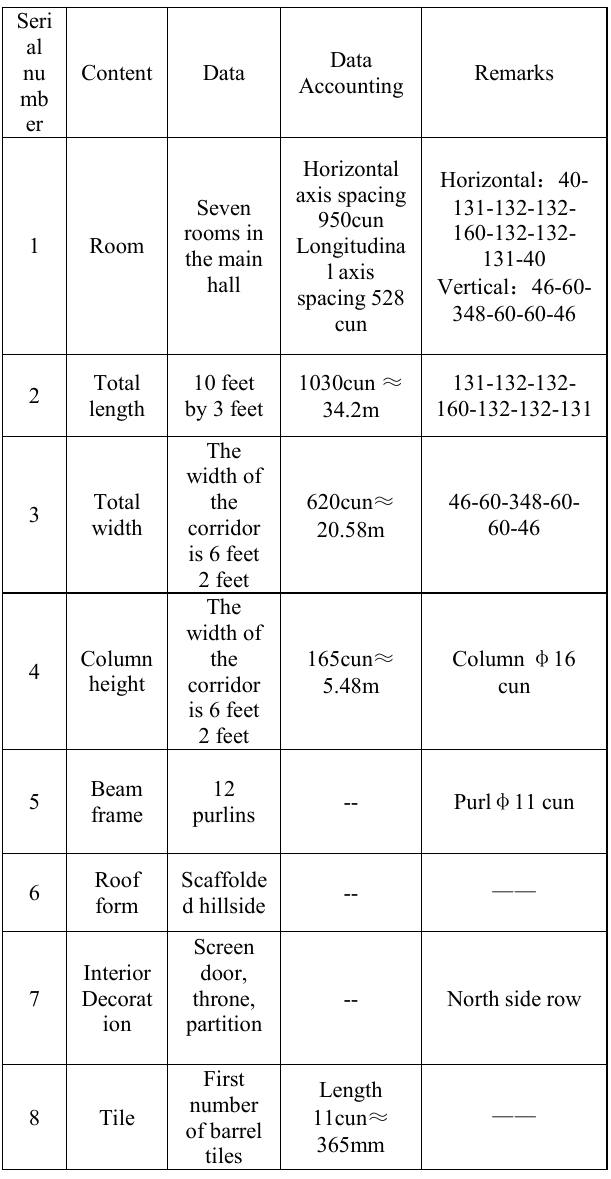
Table 3 Basic number precision table – Jiujing Sanshi Hall